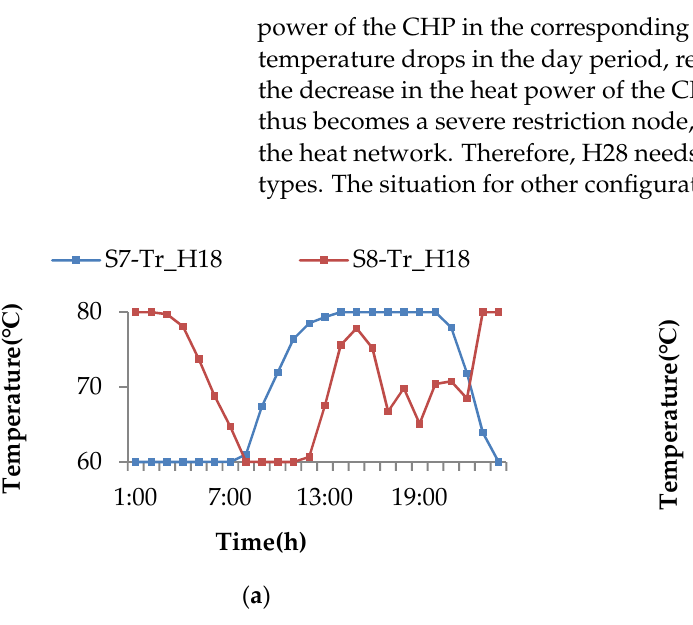
Table 8. Optimization results of configuration schemes of S7, S10 and